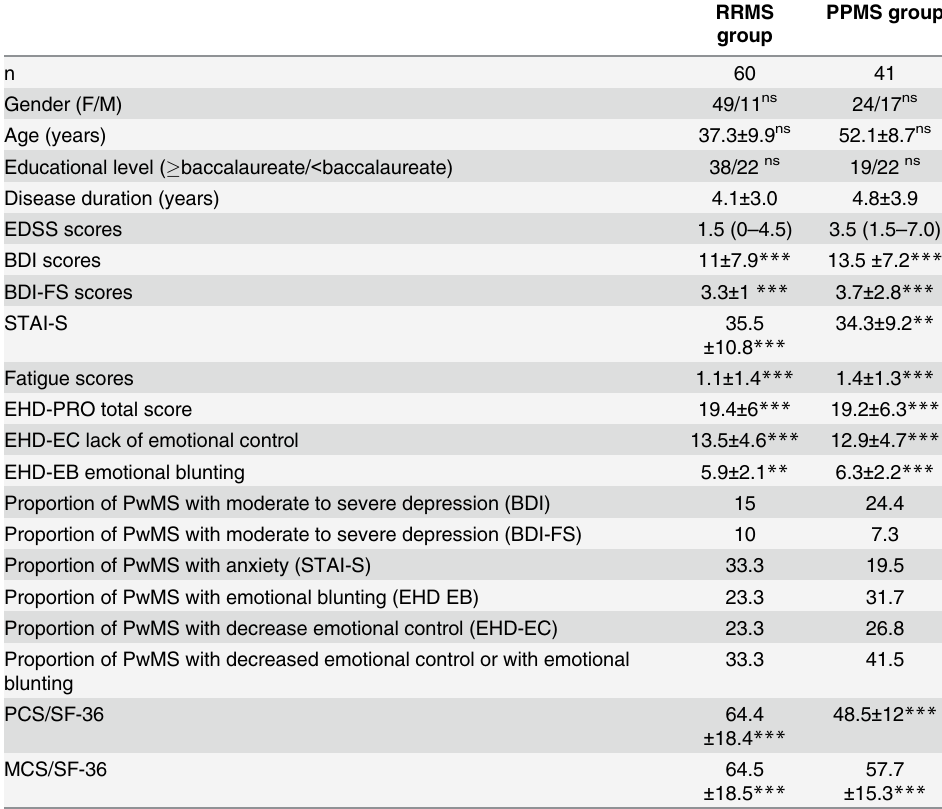
Table 1. Clinical and PRO scores of PwMS.